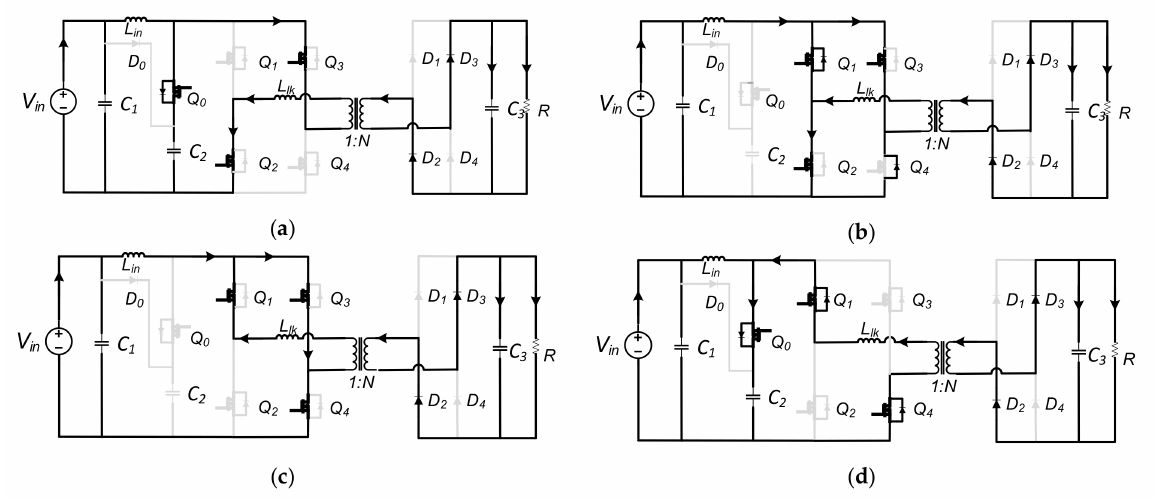
Figure 5. Circuit flow paths of step-up mode. ( a ) Stage 1 [ t 0 − t 1 ]; ( b ) Stage 2 [ t 1 − t 2 ]; ( c ) Stage 3 [ t 2 − t 3 ]; ( d ) Stage 4 [ t 3 − t 4